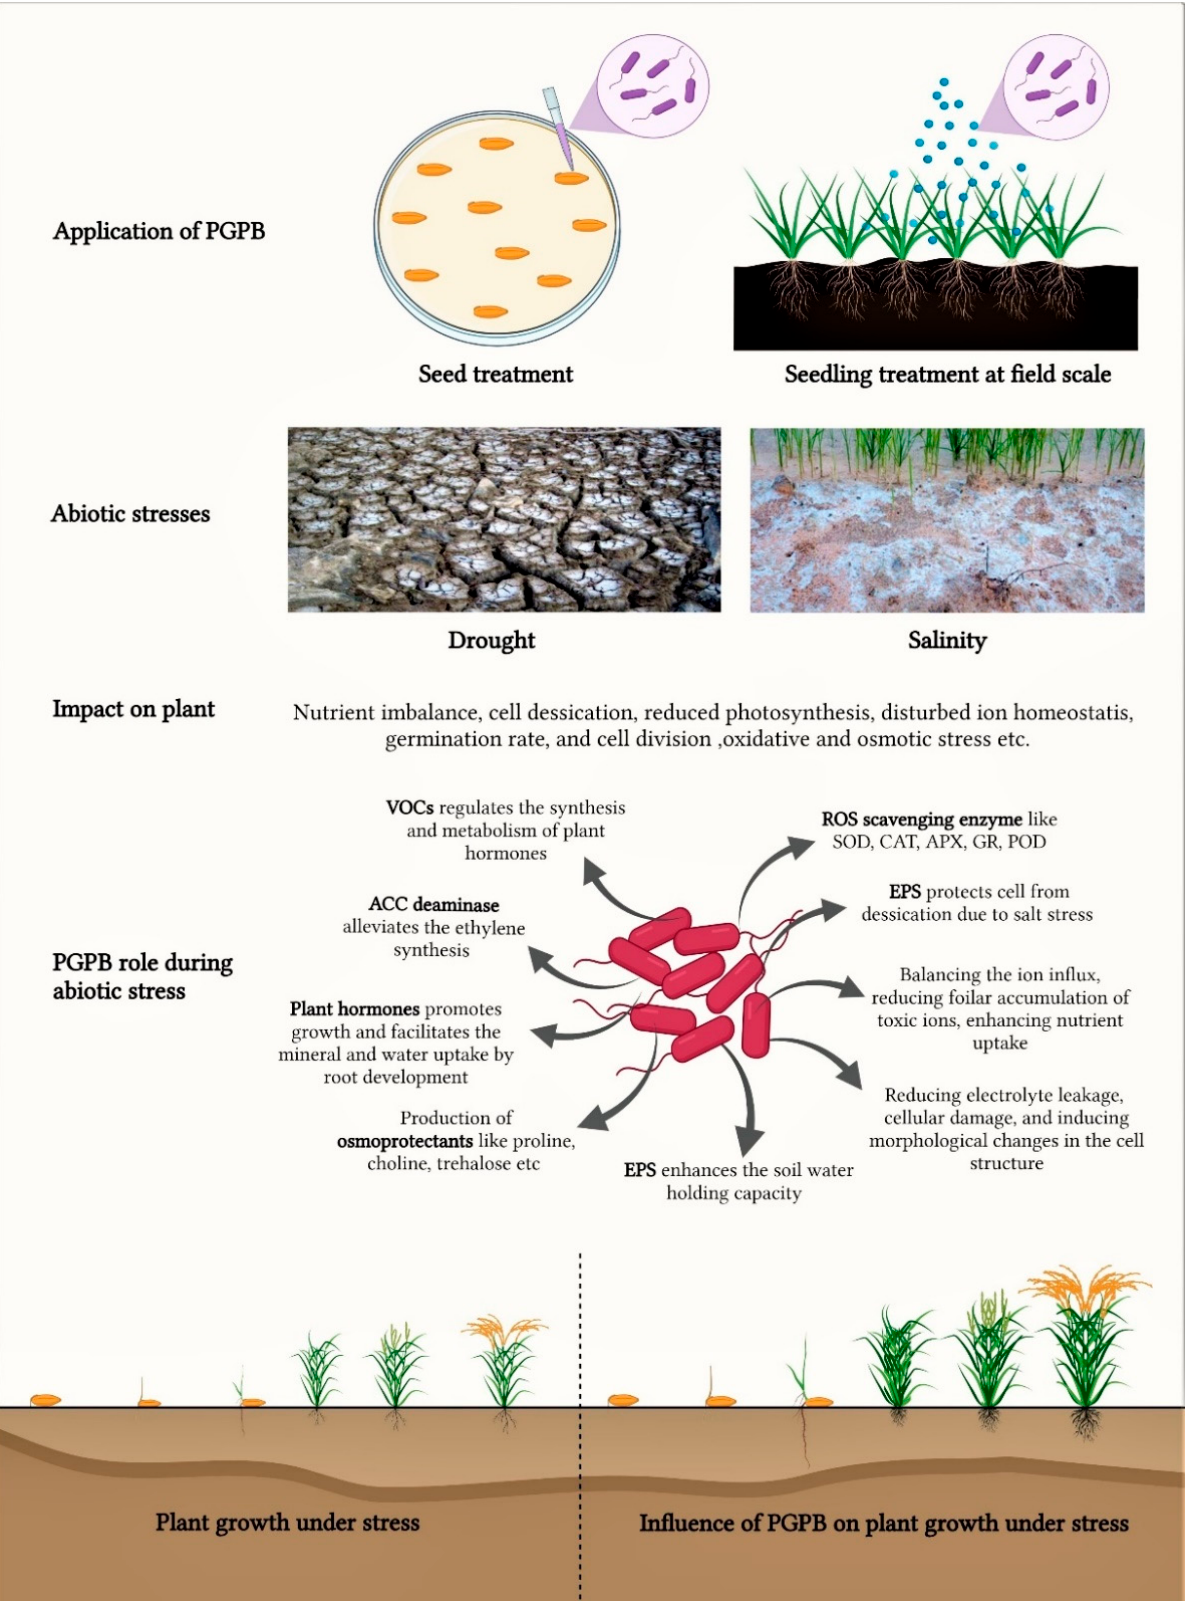
Figure 1. An overview of the role of PGPB in alleviating the effects of abiotic stress under salinity or drought.